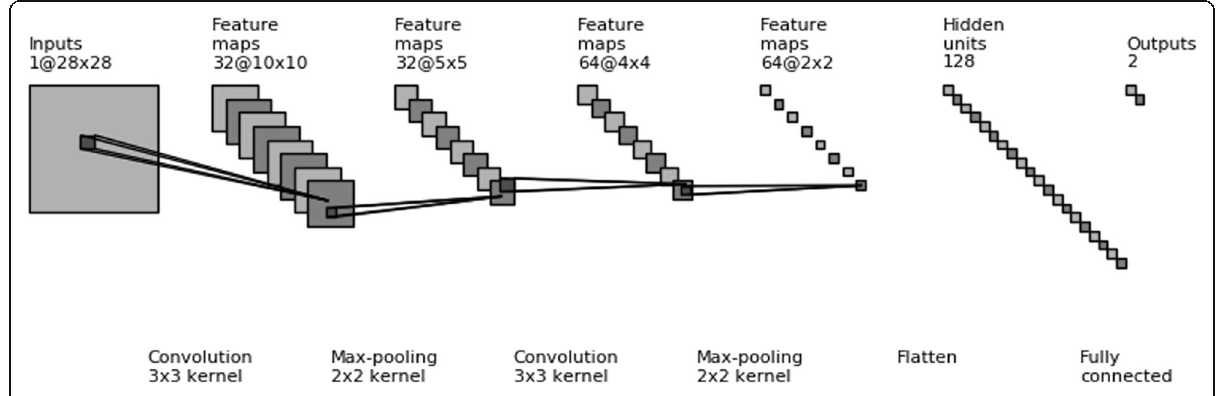
Fig. 3 CNN structure for classifying pathologic and normal sound types